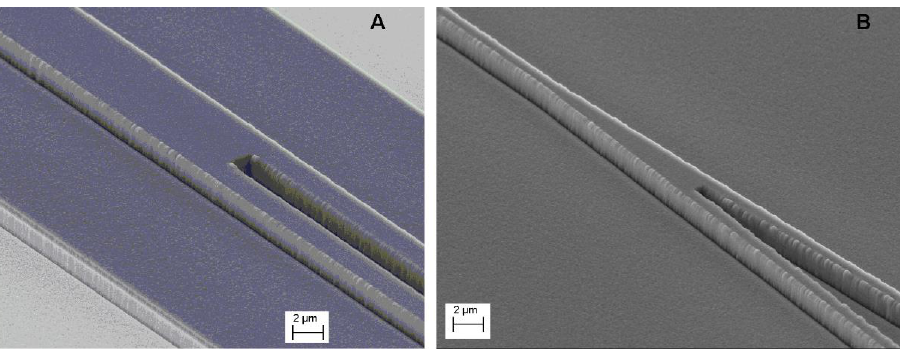
Fig. 9 . Photomicrography of optic dividers on InP semiconductor